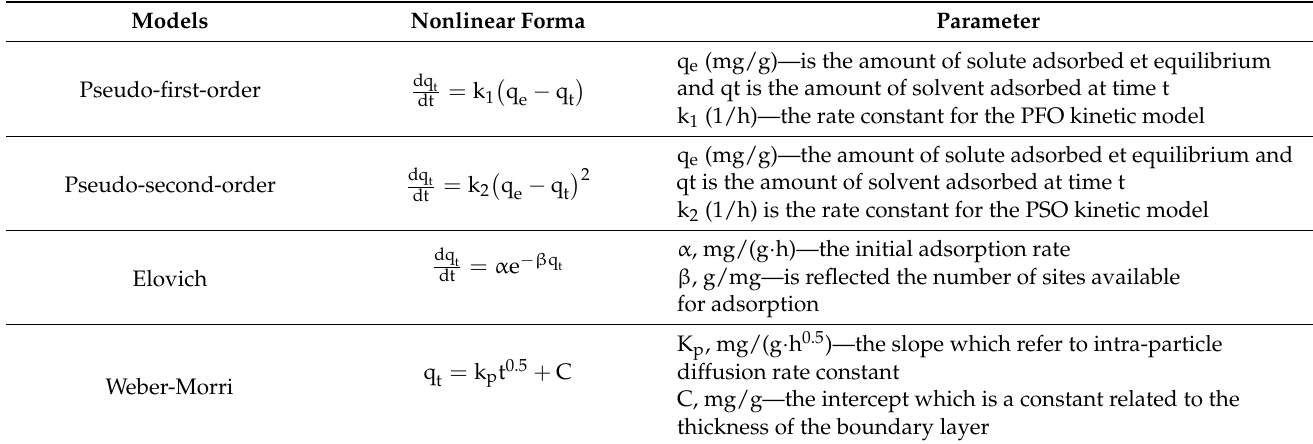
Table 3. Models of adsorption kinetics used in the paper [48,49].